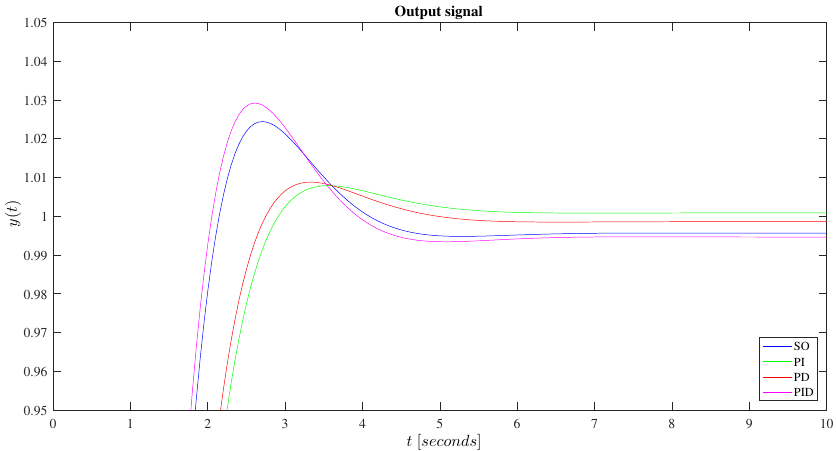
Figure 11. Detail results of y ( t ) for case